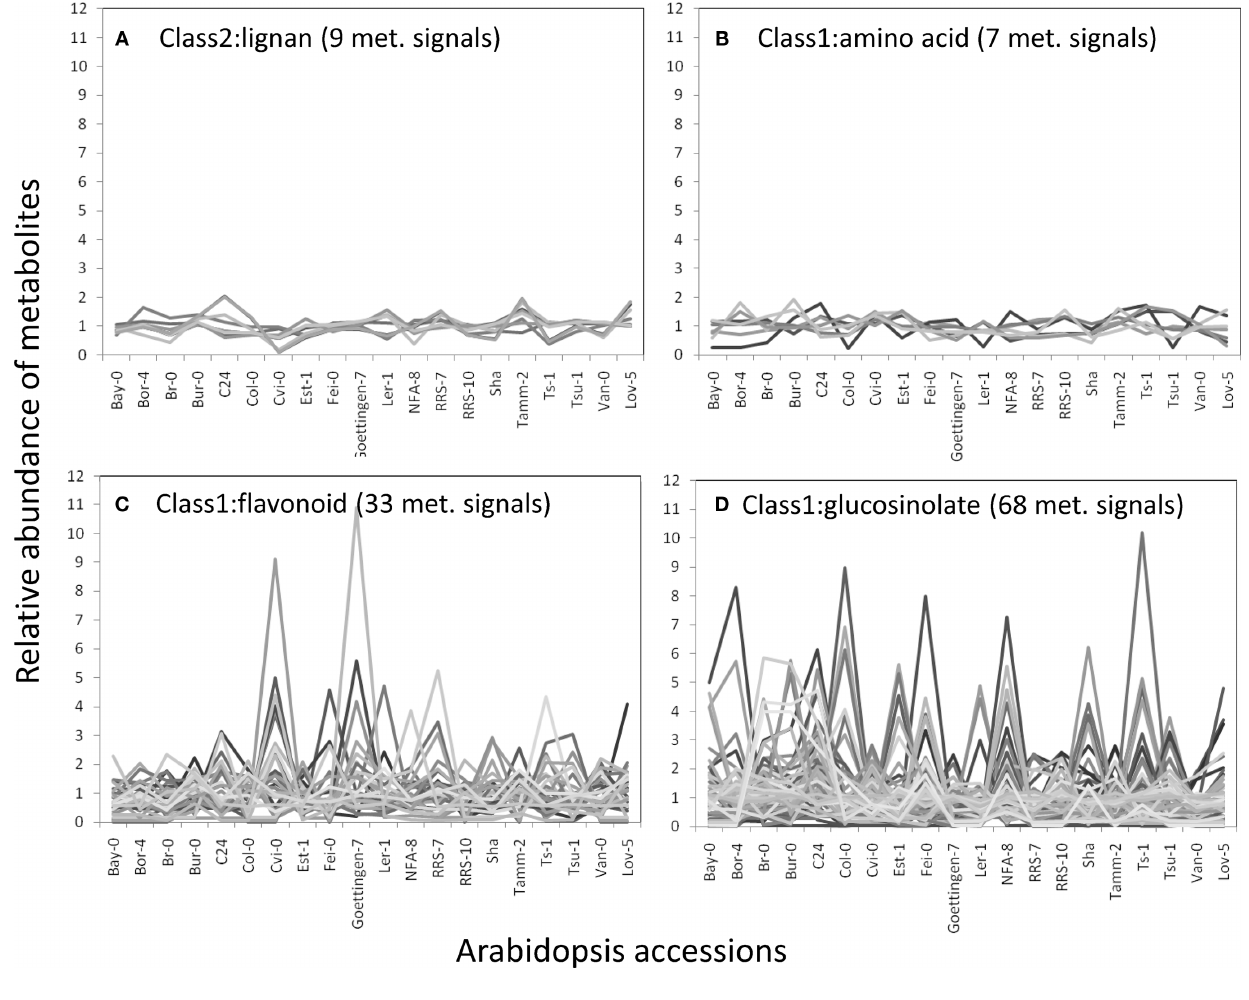
Figure 5 | Natural variation in metabolite levels among 20 Arabidopsis accessions belonging to lignan (A), amino acid (B), flavonoid (C), and glucosinolate (D). The relative abundances of metabolites were determined by dividing each metabolite level by the